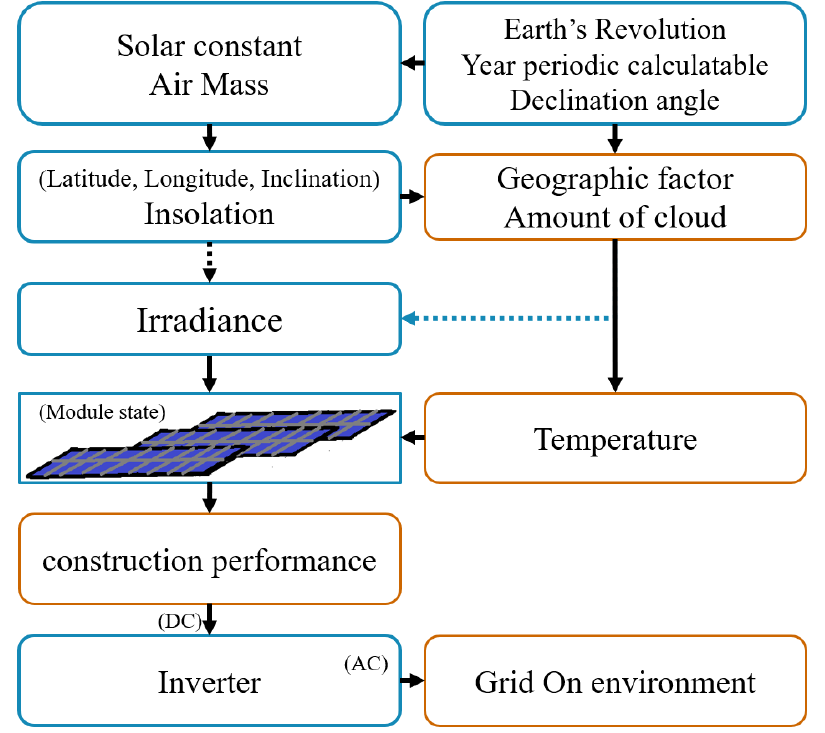
Figure 1. Dominant elements for calculating and predicting the SPV power